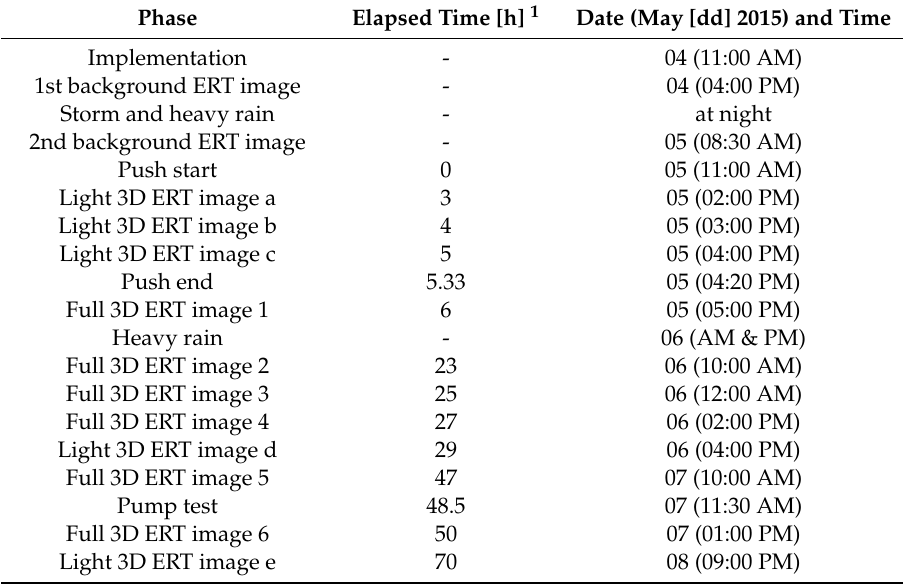
Table 2. Workflow of the